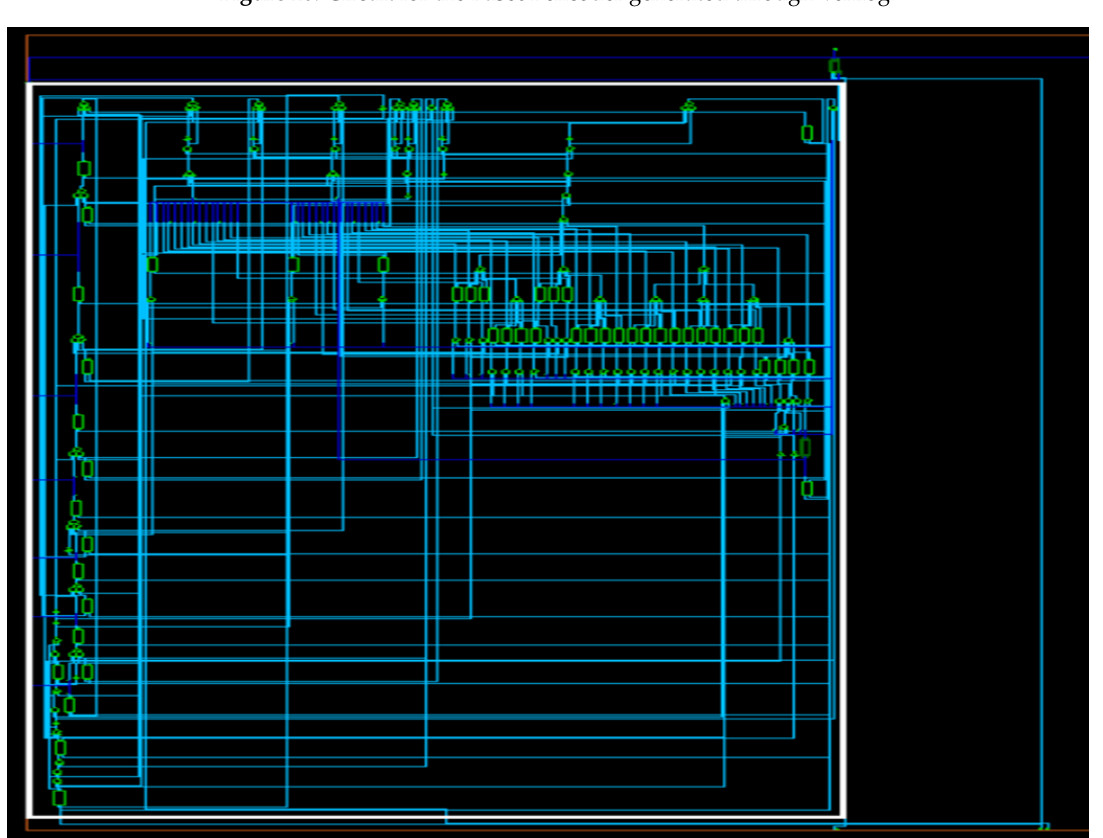
Figure 21. Circuit for the ASCII encoder (Part of Base64 Encoder) generated through